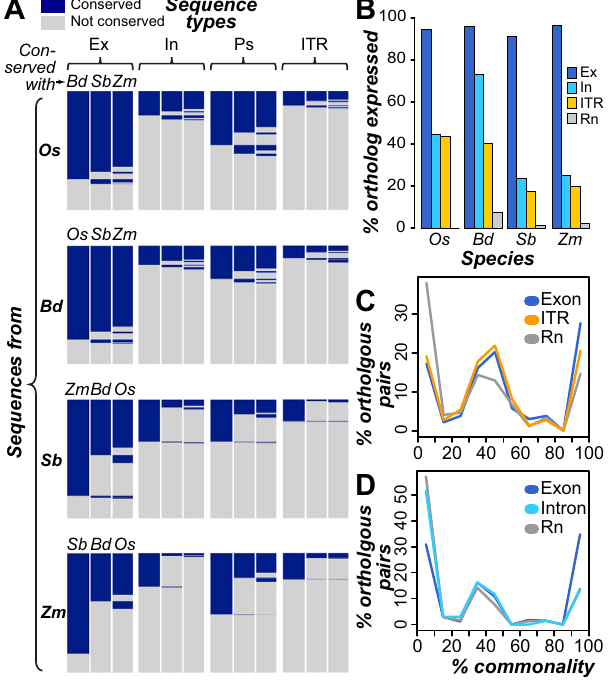
Figure 3. Sequence and expression conservation of transcribed regions. (A) Heatmaps of cross-species sequence conservation. Blue: conserved (cross-species sequence similarity significantly greater than that observed for random, unexpressed, non-repetitive intergenic sequences). Gray: not conserved. Species abbreviations follow Fig. 1. Ex: exon, In: intron, Ps: pseudogene. (B) Percentages of syntenic orthologs with expression evidence. Syntenic orthologs were identified by conservation across pairs of cross-species syntenic blocks (see Methods). Ex: exon, In: intron (C,D) Percent commonality in tissue expression between pairs of cross-species homologous exons (based on similarity but not synteny), ITR (panel C), introns (panel D), and randomly-generated expression vectors (Rn). Given the influence that expression breadth exerts on expected % commonality, comparisons among orthologous transcribed exons and random expression vectors where matched in expression breadth to that observed in orthologous ITR and transcribed intron pairs (see Methods). Note that this results in distinct distributions for transcribed exons and random expression vectors for ITRs and transcribed